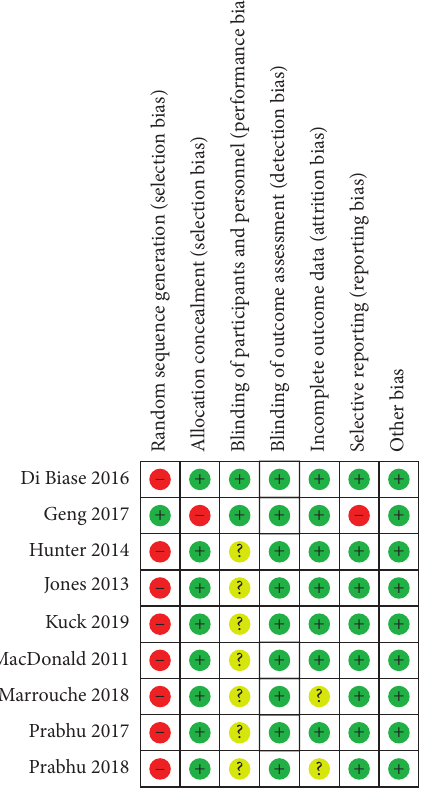
Figure 3: Summary of risk of bias of included